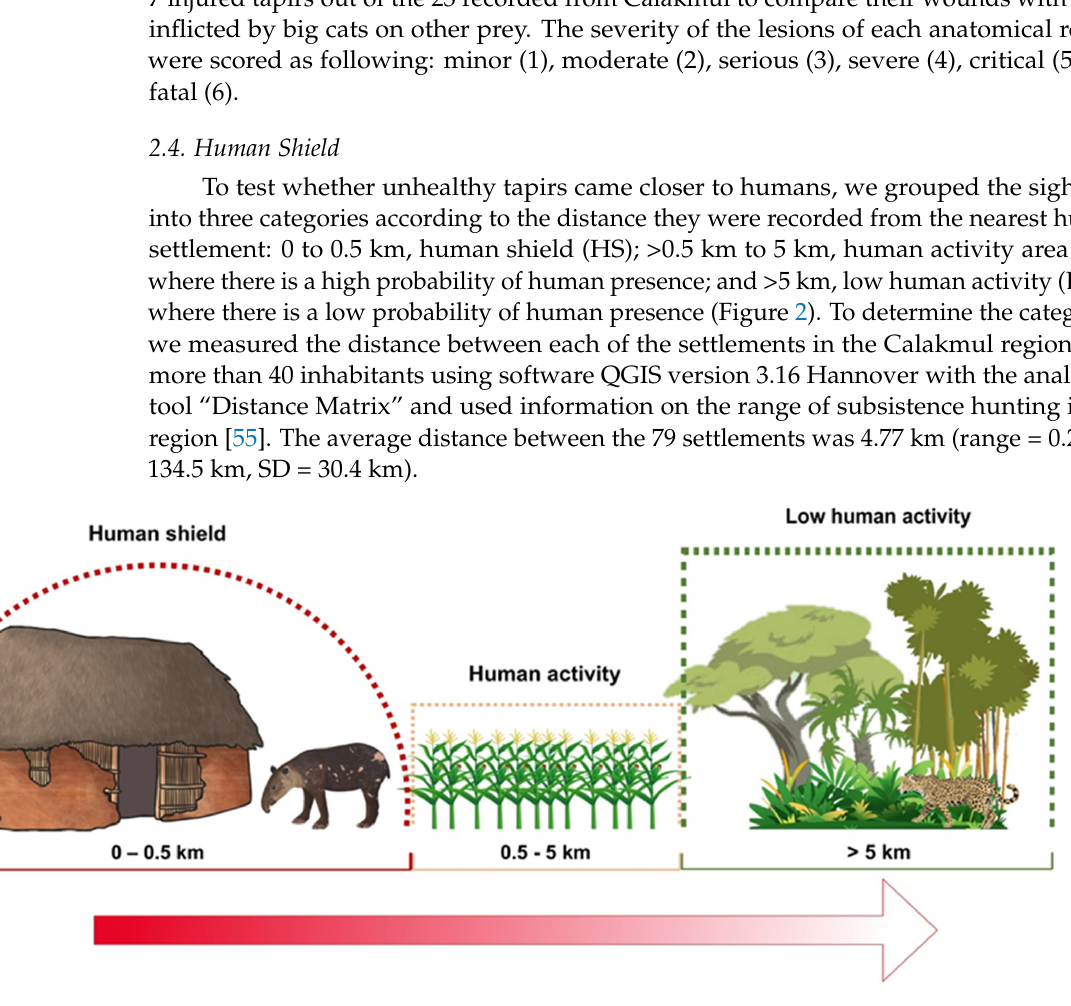
Figure 2. Schematic drawing of the categories of human activities based on their distance to human settlements where healthy and unhealthy tapirs were observed in the region of Calakmul, Campeche, Mexico. Human shield: 0 to 0.5 km; Human activity: >0.5 to 5 km; and Low human activity: >5 km).